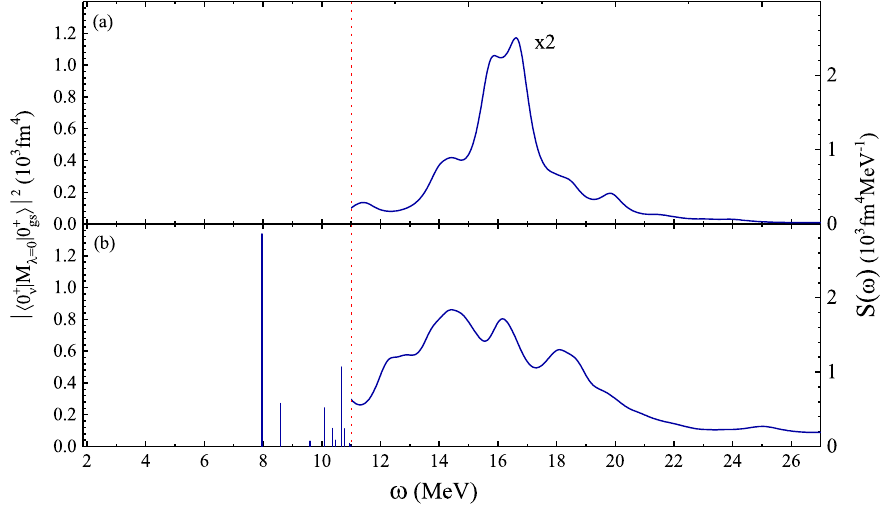
Figure 5. The Skyrme force SkM ∗ is as described in Figure